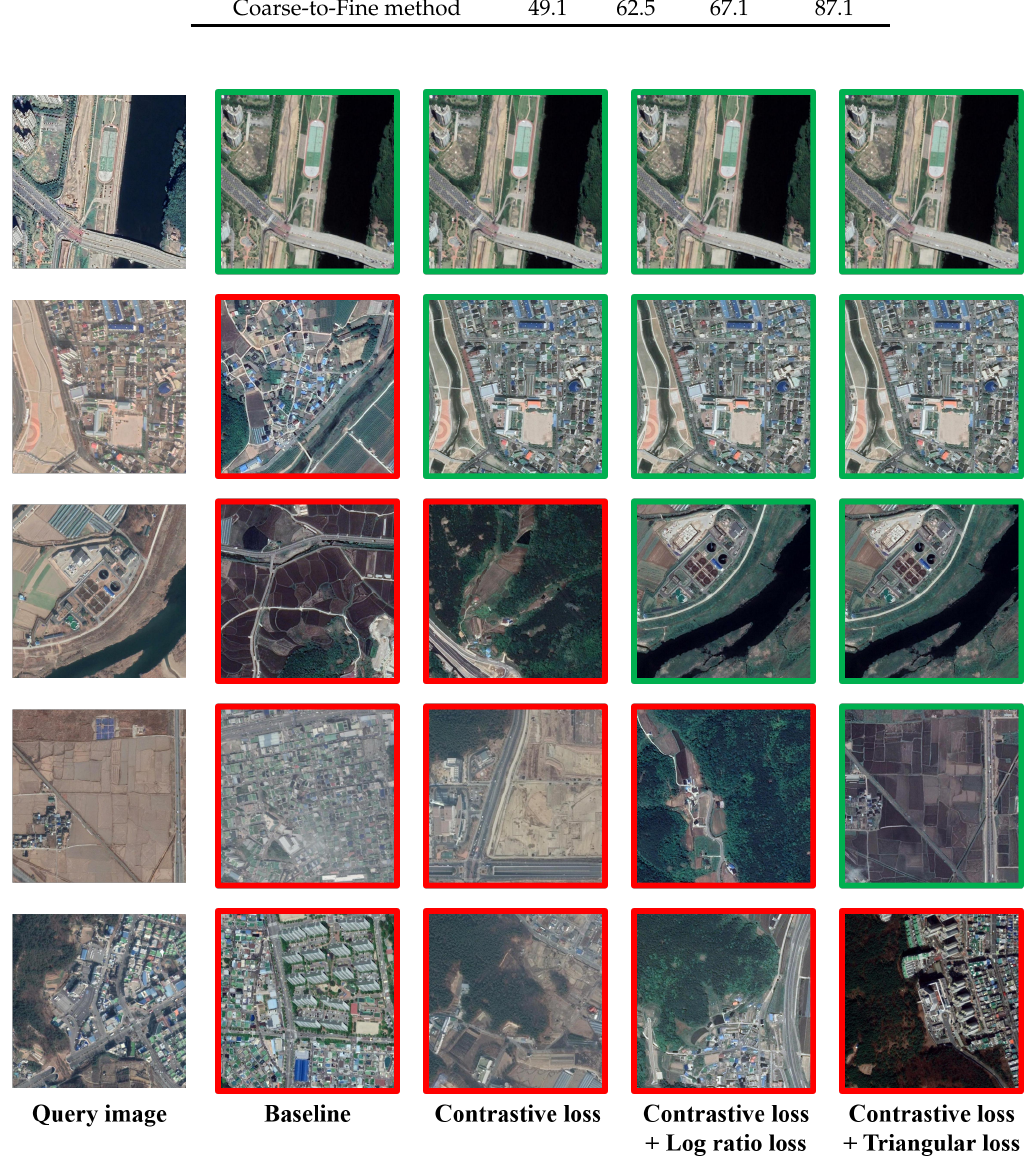
Figure 9. Examples of the retrieval results on the Google Earth South Korea dataset. Each row corresponds to one test case: the query is shown in the first column, the baseline in the second column, the coarse model in the third column, and the coarse-to-fine models in the fourth and fifth columns. Our trained network shows relatively stable retrieval results despite the variations in time instance and shooting